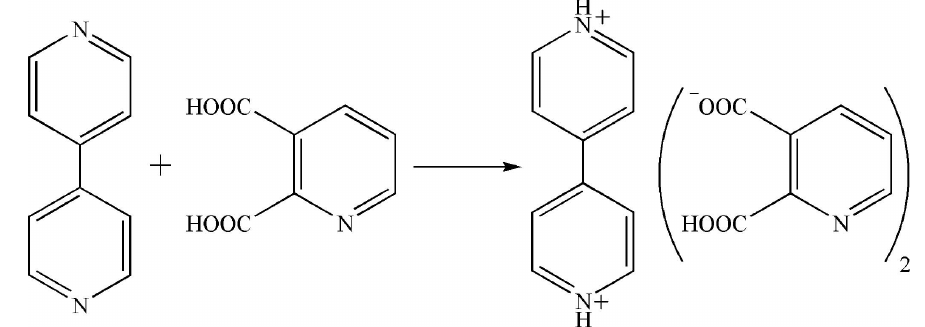
The π - π stacking in the title compound, between acid (N1/C1—C5) and base (N2/C8—C12) rings with symmetry codes: right-hand-side = - x , 1 - y , 1 - z ; left-hand-side = 1 - x , 1 - y , 1 - z .